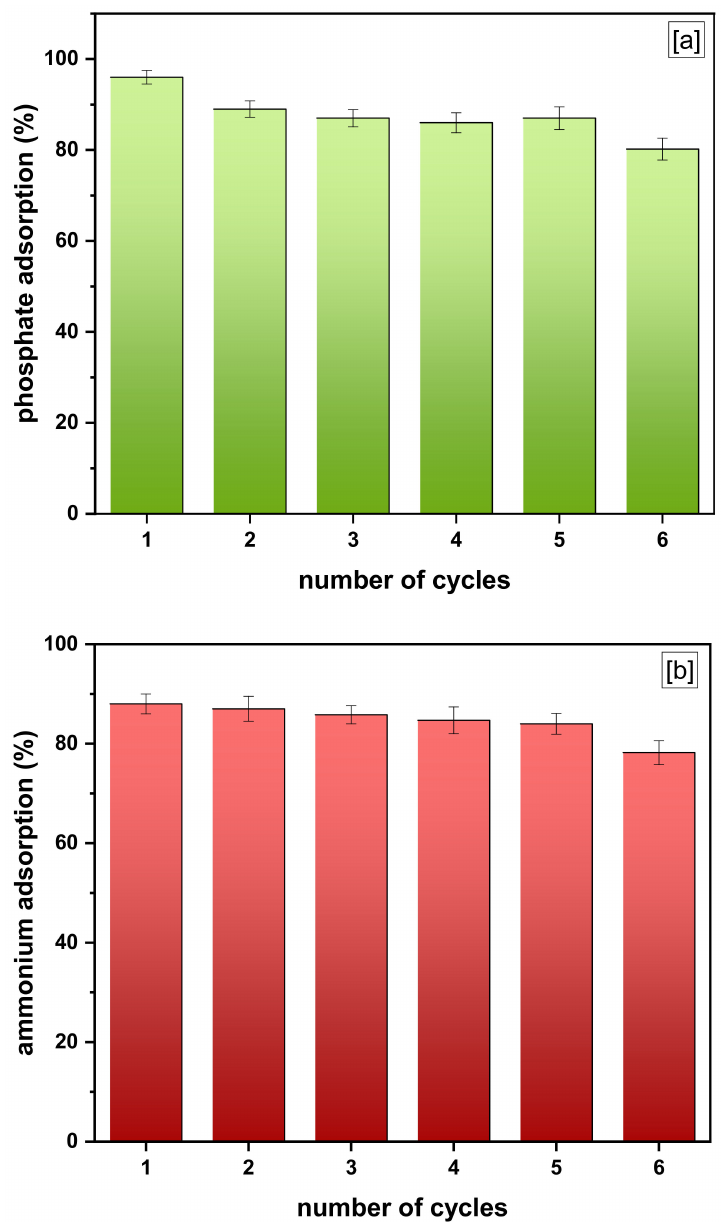
Figure 8. Regeneration and reuse studies of f -MB for the removal of ( a ) phosphate and ( b )